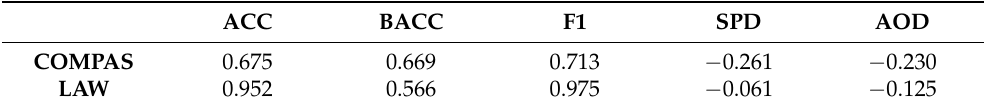
Table 4. LRC baseline results. Performance was evaluated using stratified 10-fold CV. For SPD and AOD, values closer to zero indicate more fairness. ACC BACC F1 SPD AOD COMPAS 0.675 0.669 0.713 − 0.261 − 0.230 LAW 0.952 0.566 0.975 − 0.061 −